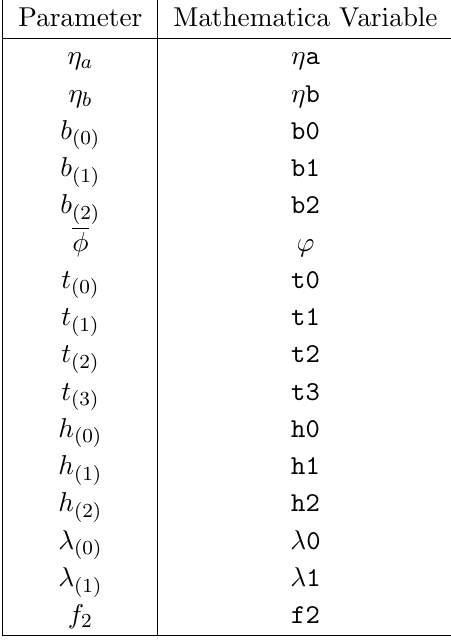
Table 9 . Mathematica variables corresponding to the parameters in the q = 3 model.